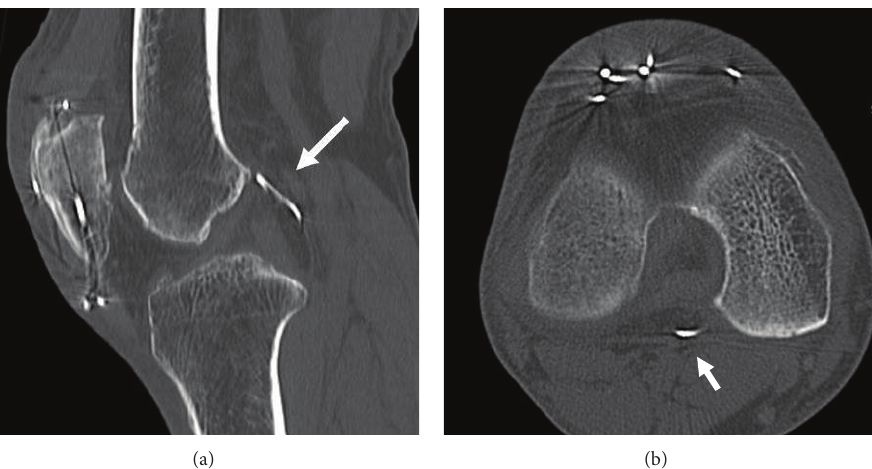
Figure 4: Computed tomography, (a) sagittal and (b) axial views. We could not determine from the scan whether the wire fragment was in the posterior compartment of the knee joint or popliteal